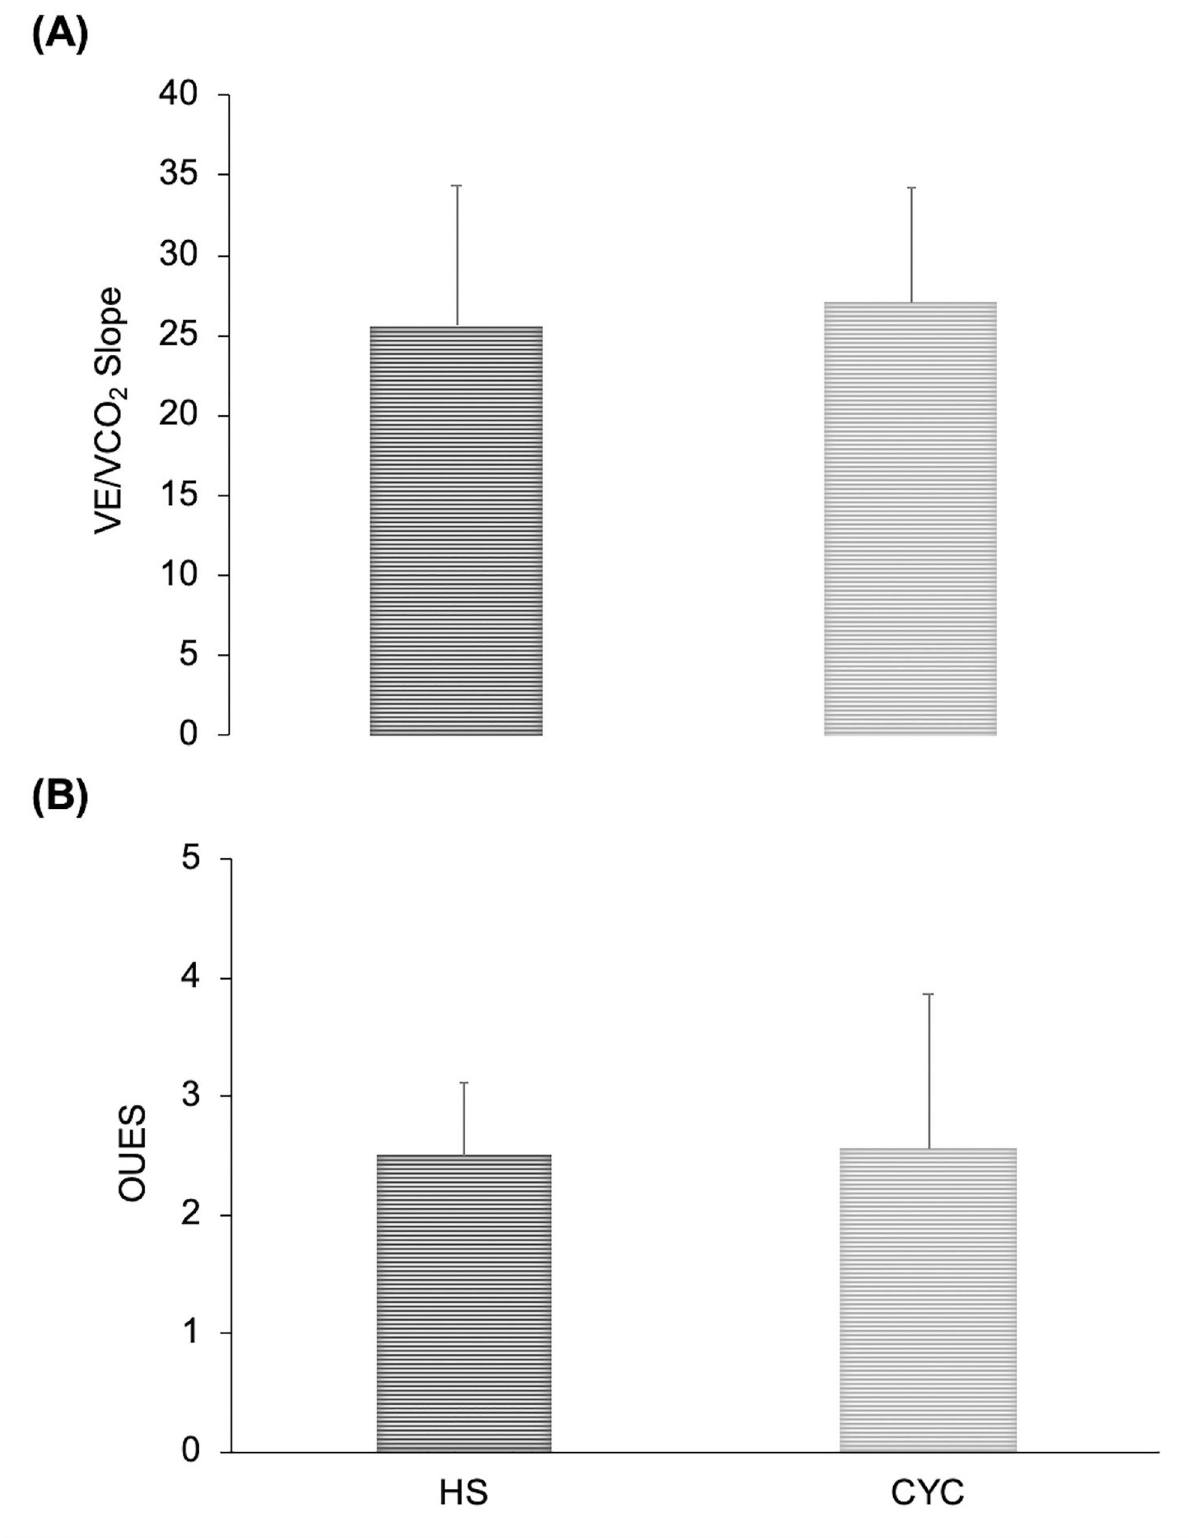
Fig 3. Differences between cycle ergometer (CYC) and half-squat (HS) in the VE/VCO 2 slope and OUES. No significant differences between both exercise modalities. https://doi.org/10.1371/journal.pone.0216824.g003 PLOS ONE | https://doi.org/10.1371/journal.pone.0216824 May 21,